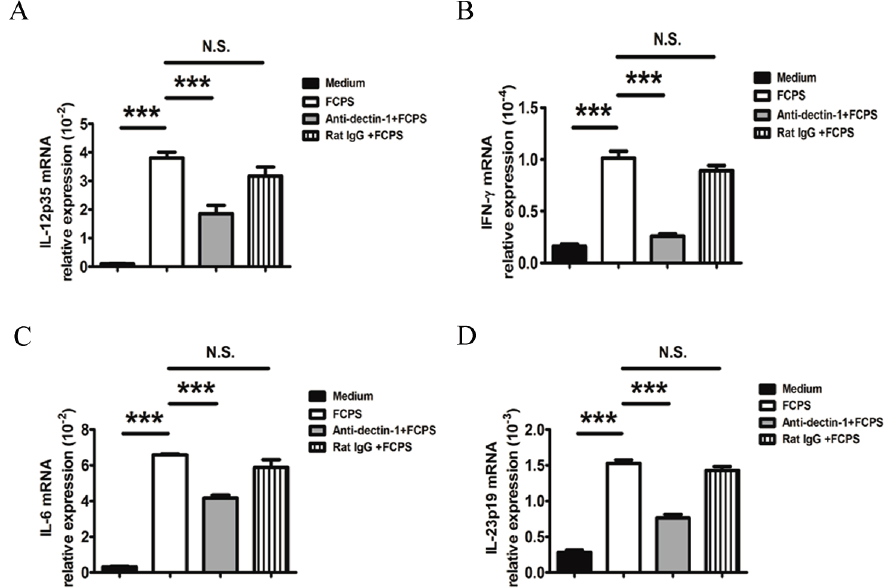
Figure 3. FCPS alter the expression of multiple cytokines secreted by BMDCs. ( A – D ) BMDCs were stimulated with FCPS (100 μ g/mL) for 24 h with or without anti-dectin-1 antibody or rat IgG (5 μ g/mL). Cells were collected and mRNA levels of IL-12p35 ( A ); IFN- γ ( B ); IL-6 ( C ); and IL-23p19 ( D ) were measured by qRT-PCR. All data are shown as means ± SD from three independent experiments. *** p < 0.001, N.S. no significance.